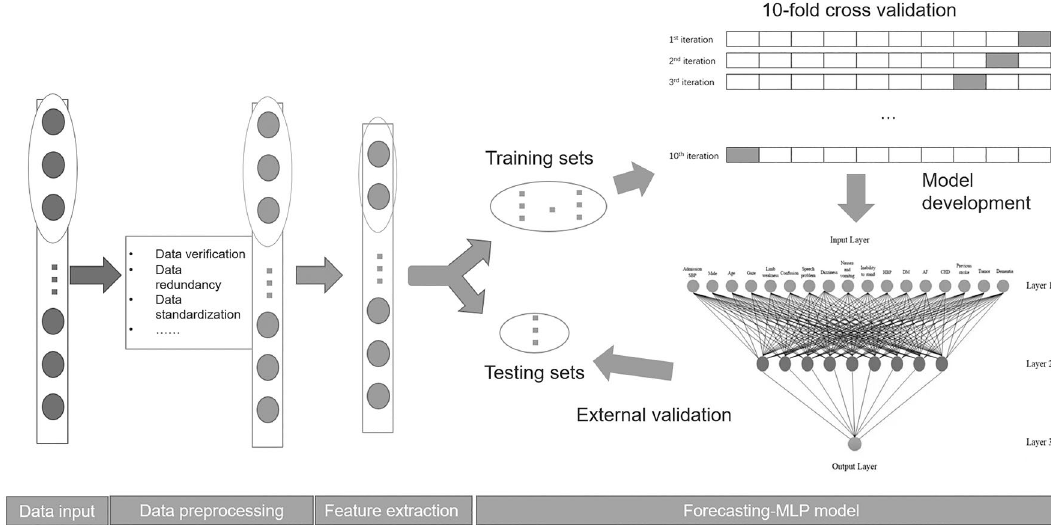
Figure 3. A flowchart of model development process. There are four steps in constructing an MLP model: data input, data preprocessing, feature extraction, and forecasting-MLP model.